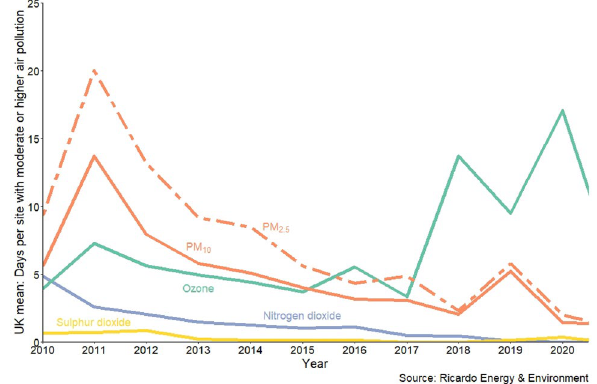
Figure 3. UK mean days per (urban) site with moderate or higher air pollution by year (from DEFRA report 47 ).